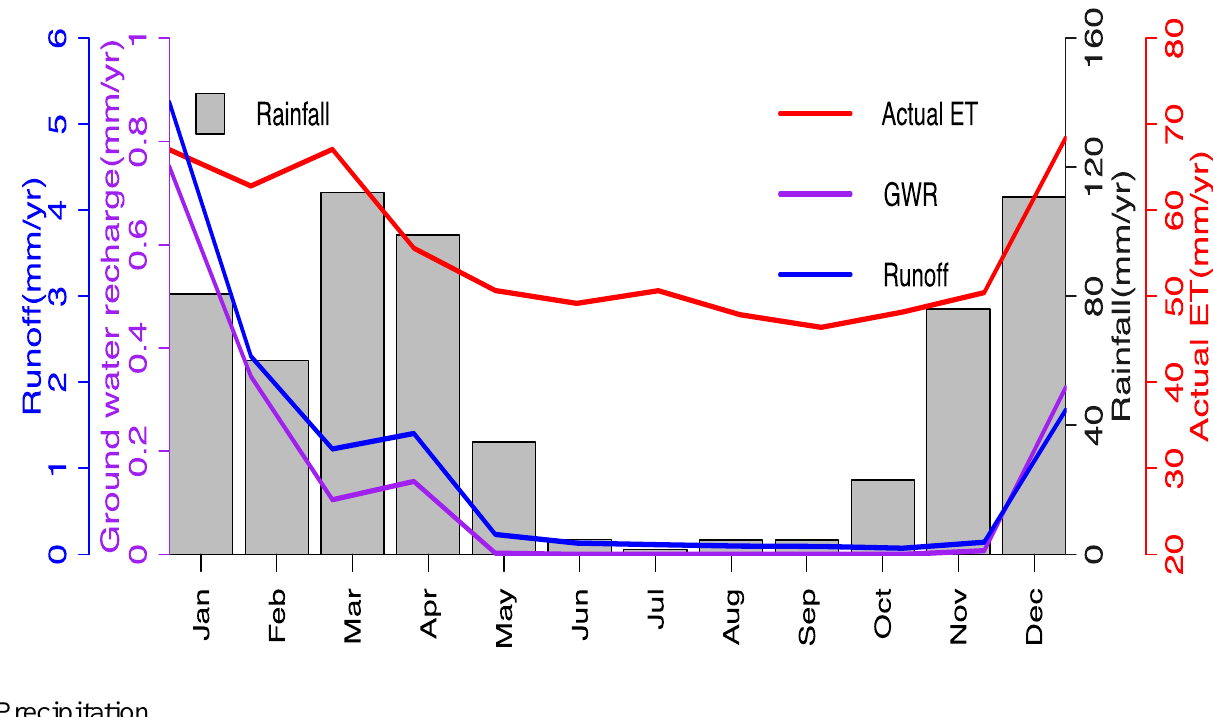
Figure 10. Mean monthly annual water balance parameter variation for Lake Manyara catchment